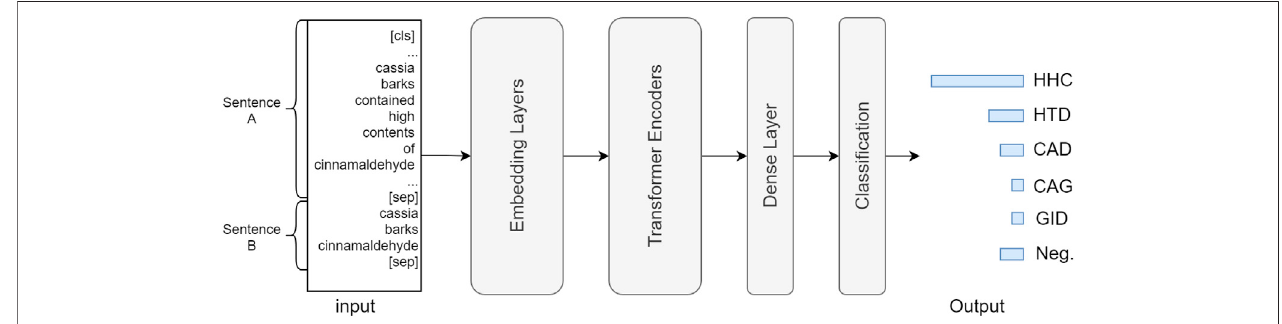
FIGURE 5| Neural architecture ofBERT-based REmodel. The input consists ofsentence (A,B) , in which A isa concatenation ofthe title and the abstract content, and (B) includes thehead and tail entity mentions. (A) (sep)token isplaced at the end ofeach sentence asaseparator. The inputisprocessed through token, sentence, andpositionalembeddinglayersandthenfedintoasequenceoftransformerencoderlayers.Lastly,theoutputofthe N thtransformerpassesadenseandaclassi fi cation (softmax) layer to generate the prediction